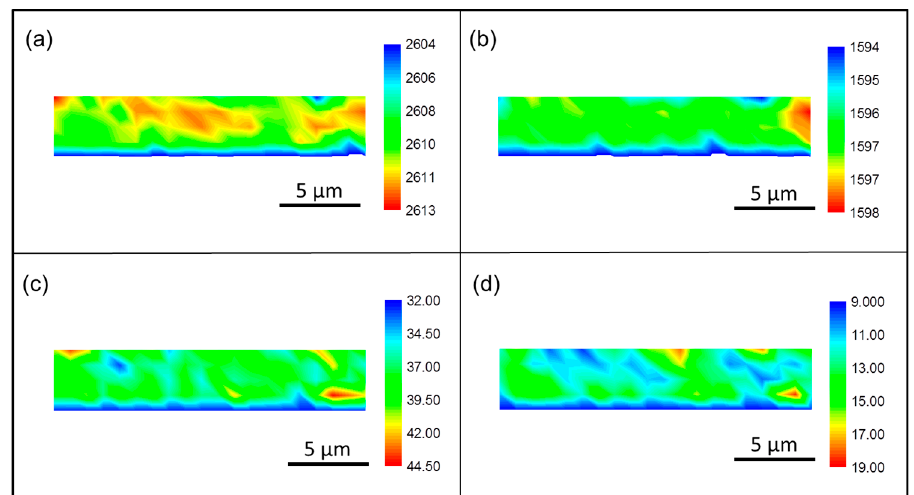
Figure 3. Characteristic contour maps of ( a ) Pos(2D), ( b ) Pos(G), ( c ) FWHM (2D), and ( d ) FWHM(G) of PMMA-embedded graphene micro-ribbon. Table 1. Mean values and standard deviation of the position and FWHM of G and 2D bands for the PMMA-embedded micro-ribbons.